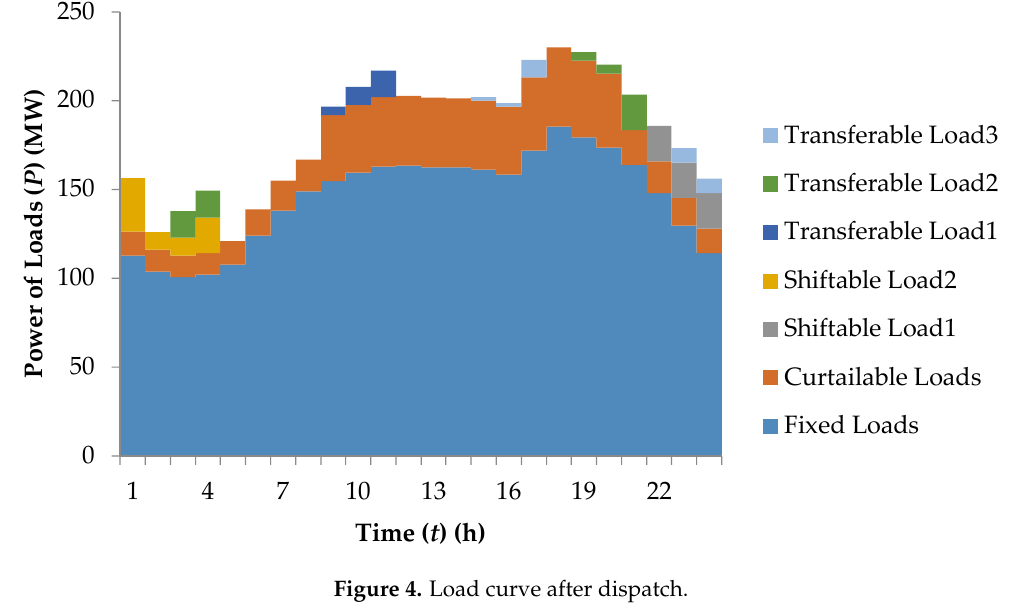
Table 4. Power consumption of transferable loads after dispatch.